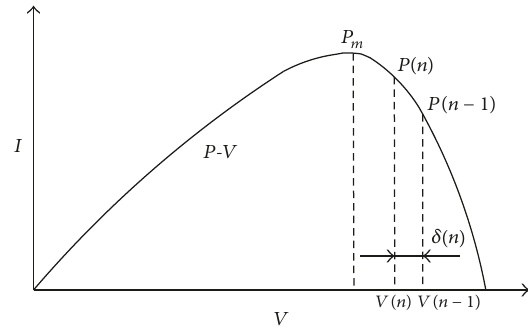
Figure 2: P&O curve of solar array.